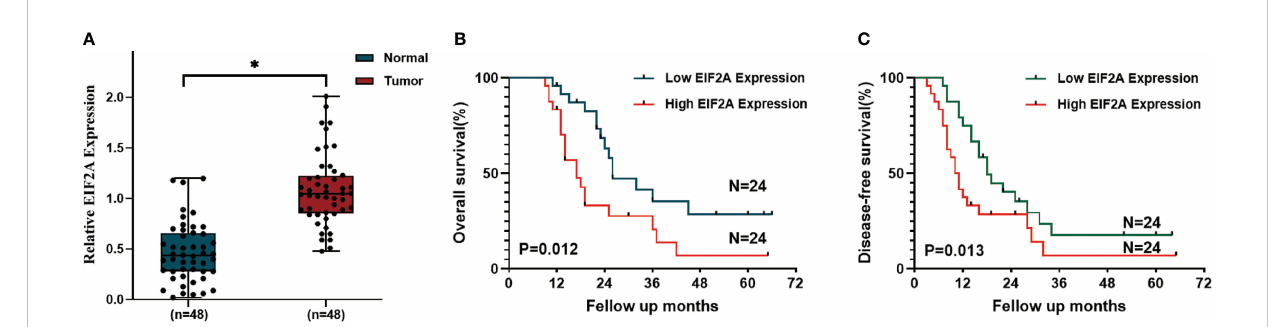
FIGURE 6 The correlation between EIF2A expression and prognosis of PDAC patients. (A) The relative amount of EIF2A expression in PDAC tissues and normal pancreatic tissues as determined by RT-qPCR. (B, C) Kaplan – Meier curves of OS and DFS in EIF2A-high and EIF2A-low subtypes. *P <